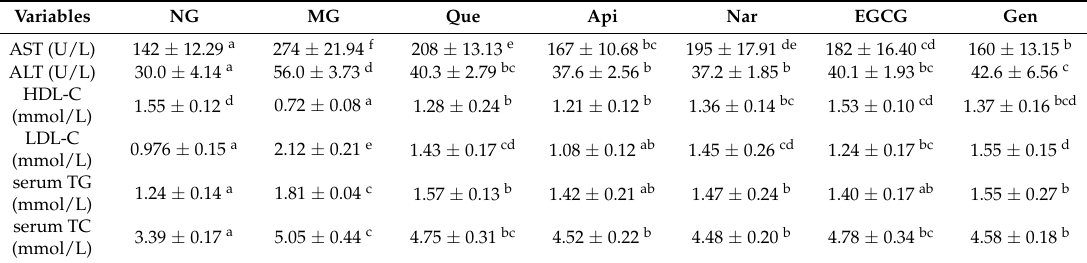
Table 1. Effect of five kinds of flavonoids on serum biochemical markers in mice 1